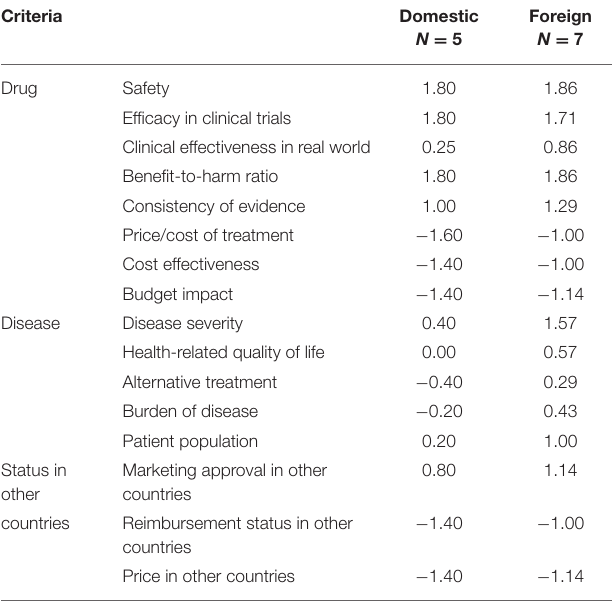
TABLE 1 | Relevance of criteria in regulatory decision-making on new drugs.